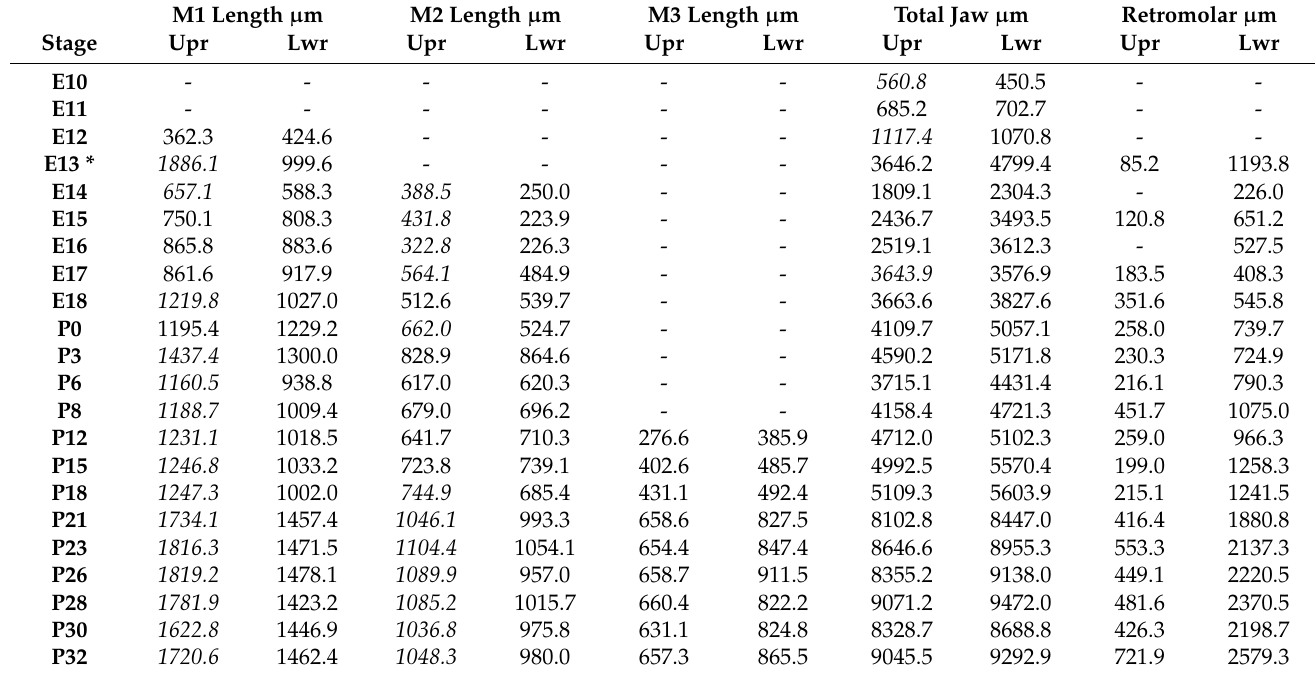
Table 4. Upper (M x /Upr) and lower (M x /Lwr) first (M1), second (M2) and third (M3) molar, total jaw and retromolar mean mesiodistal lengths in micrometers ( µ m) for each prenatal (E) and postnatal (P) stage studied here. Per stage, all measurements for left and right sides were averaged. Typically, M 1 > M 1 (15/20 stages) and M 2 > M 2 (12/18 stages), while M 3 > M 3 for 9/9 stages ( italicized values = Upr > Lwr). Total jaw length was longer in the lower jaw with three